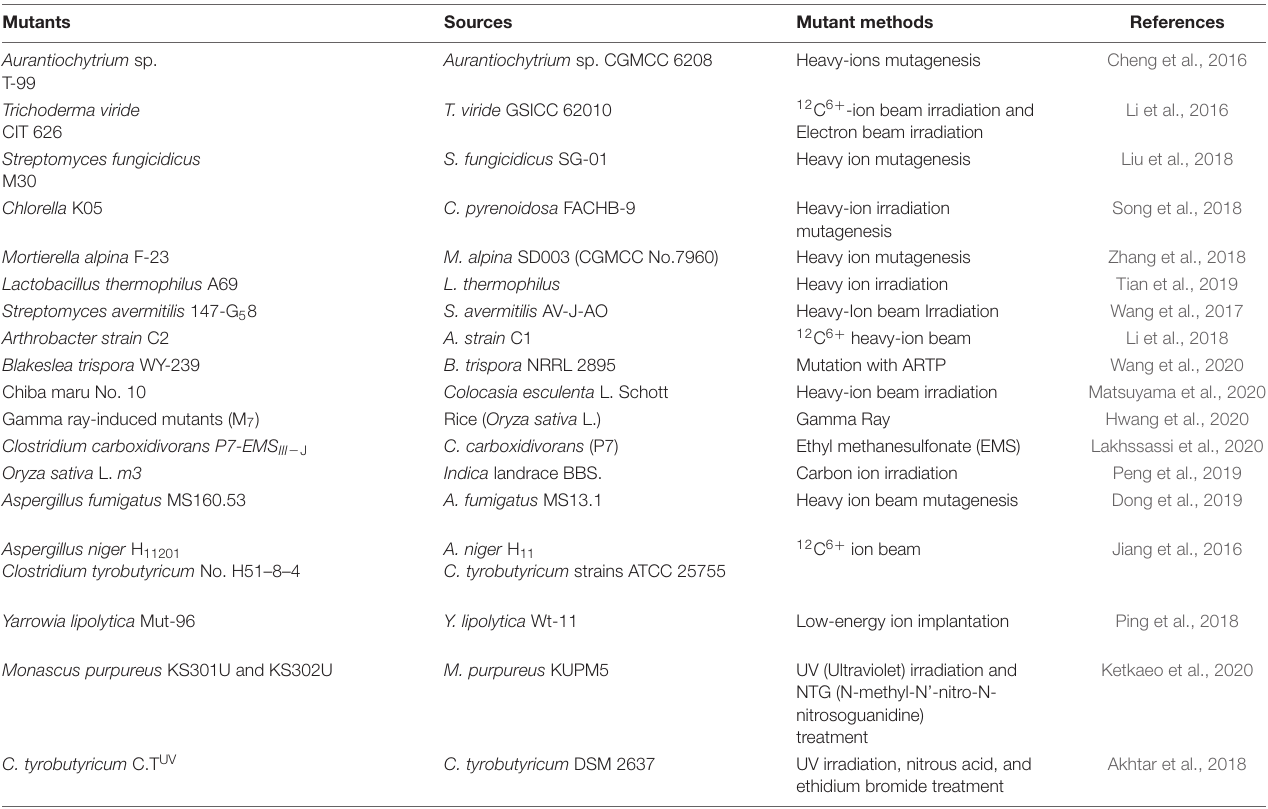
TABLE 1 | Traditional mutagenesis methods and heavy-ion irradiation with the reported mutation methods are widely used in strain